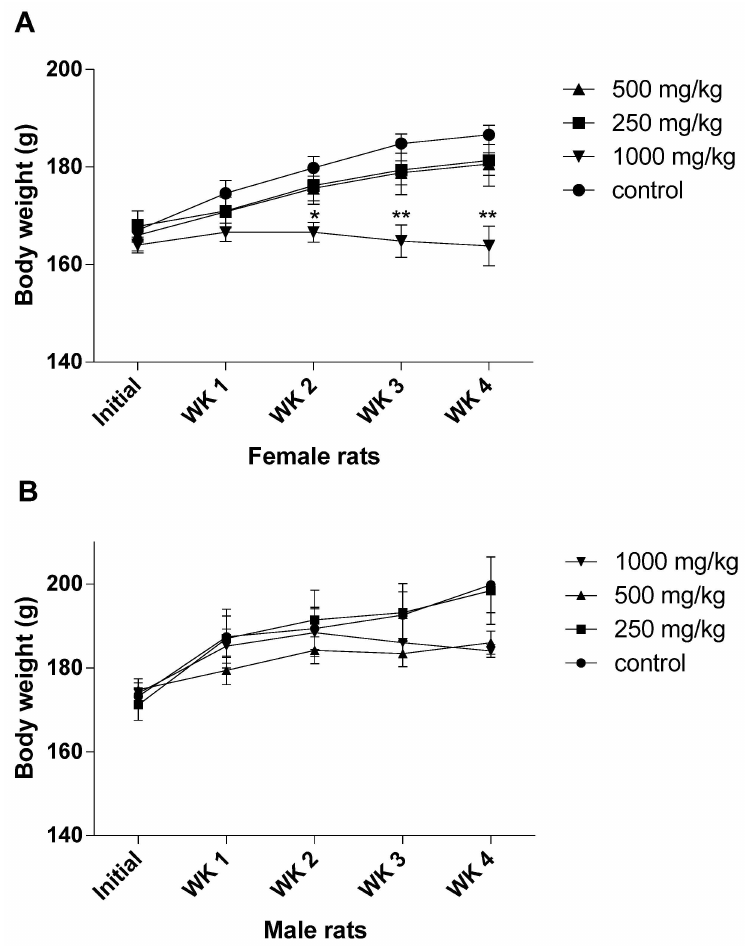
Figure 2. Initial and weekly (WK) body weight measurements (g) of the male ( A ) and female ( B ) rats in the sub-acute toxicity study of the methanolic extract of Alstonia scholaris . Results were expressed as the mean ˘ S.E.M. of 5 rats. (Significantly different from the control; * p < 0.05; ** p < 0.01).